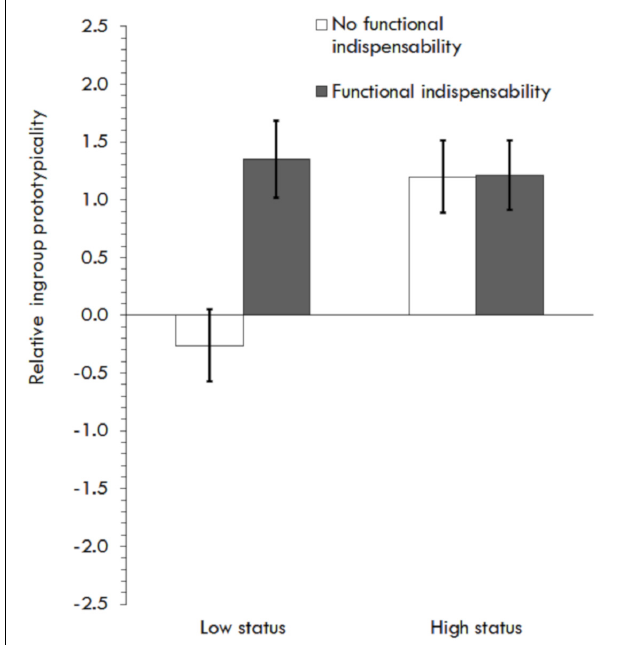
FIGURE 3 | Effects of relative ingroup prototypicality depending on functional indispensability and status in Study